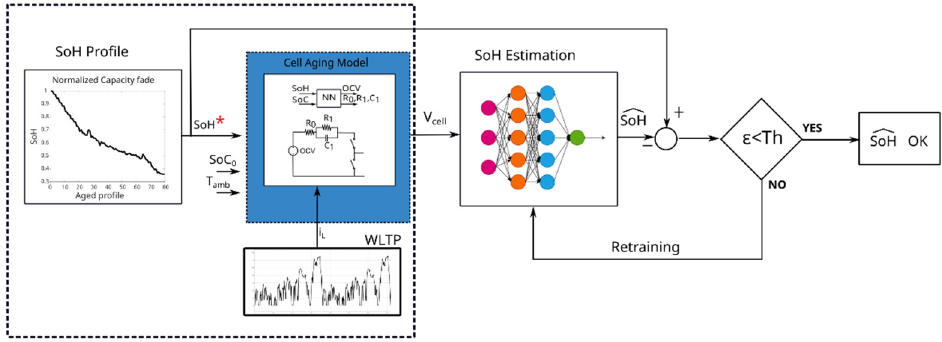
Figure 10. Training of SOH estimation using CAM BDT. SOH* represents the reference value.